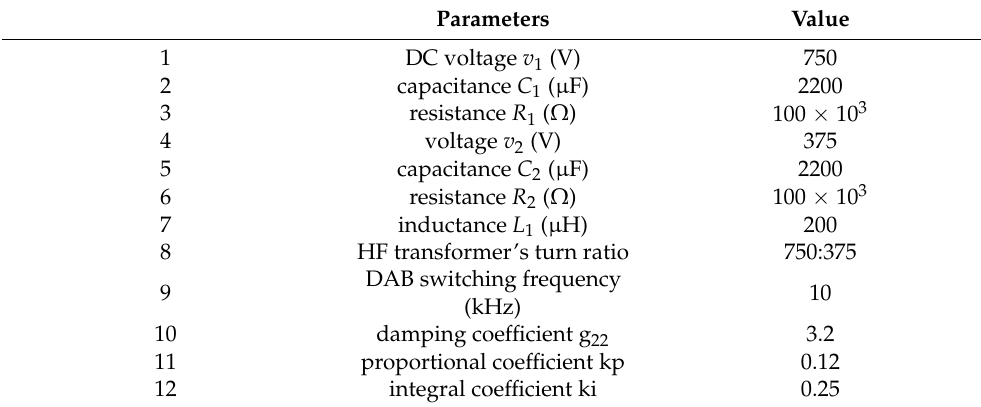
Table 1. Main parameters of DAB converter.